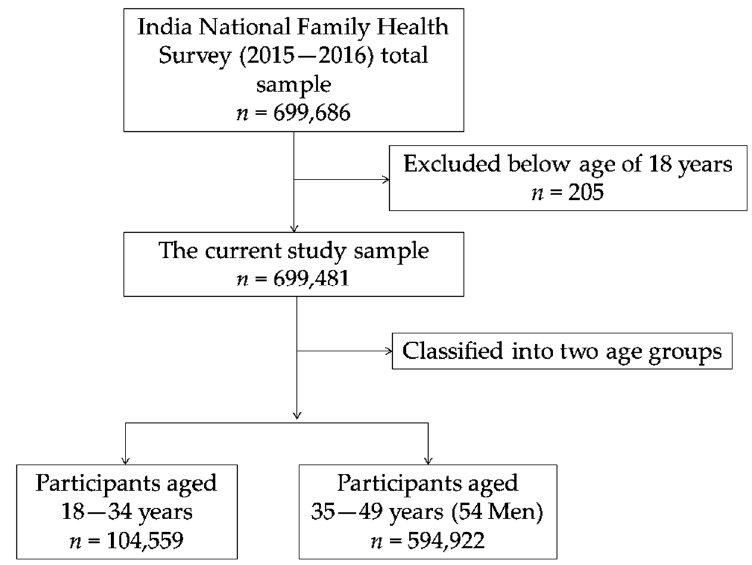
Figure 1. The flowchart of the current study sample.